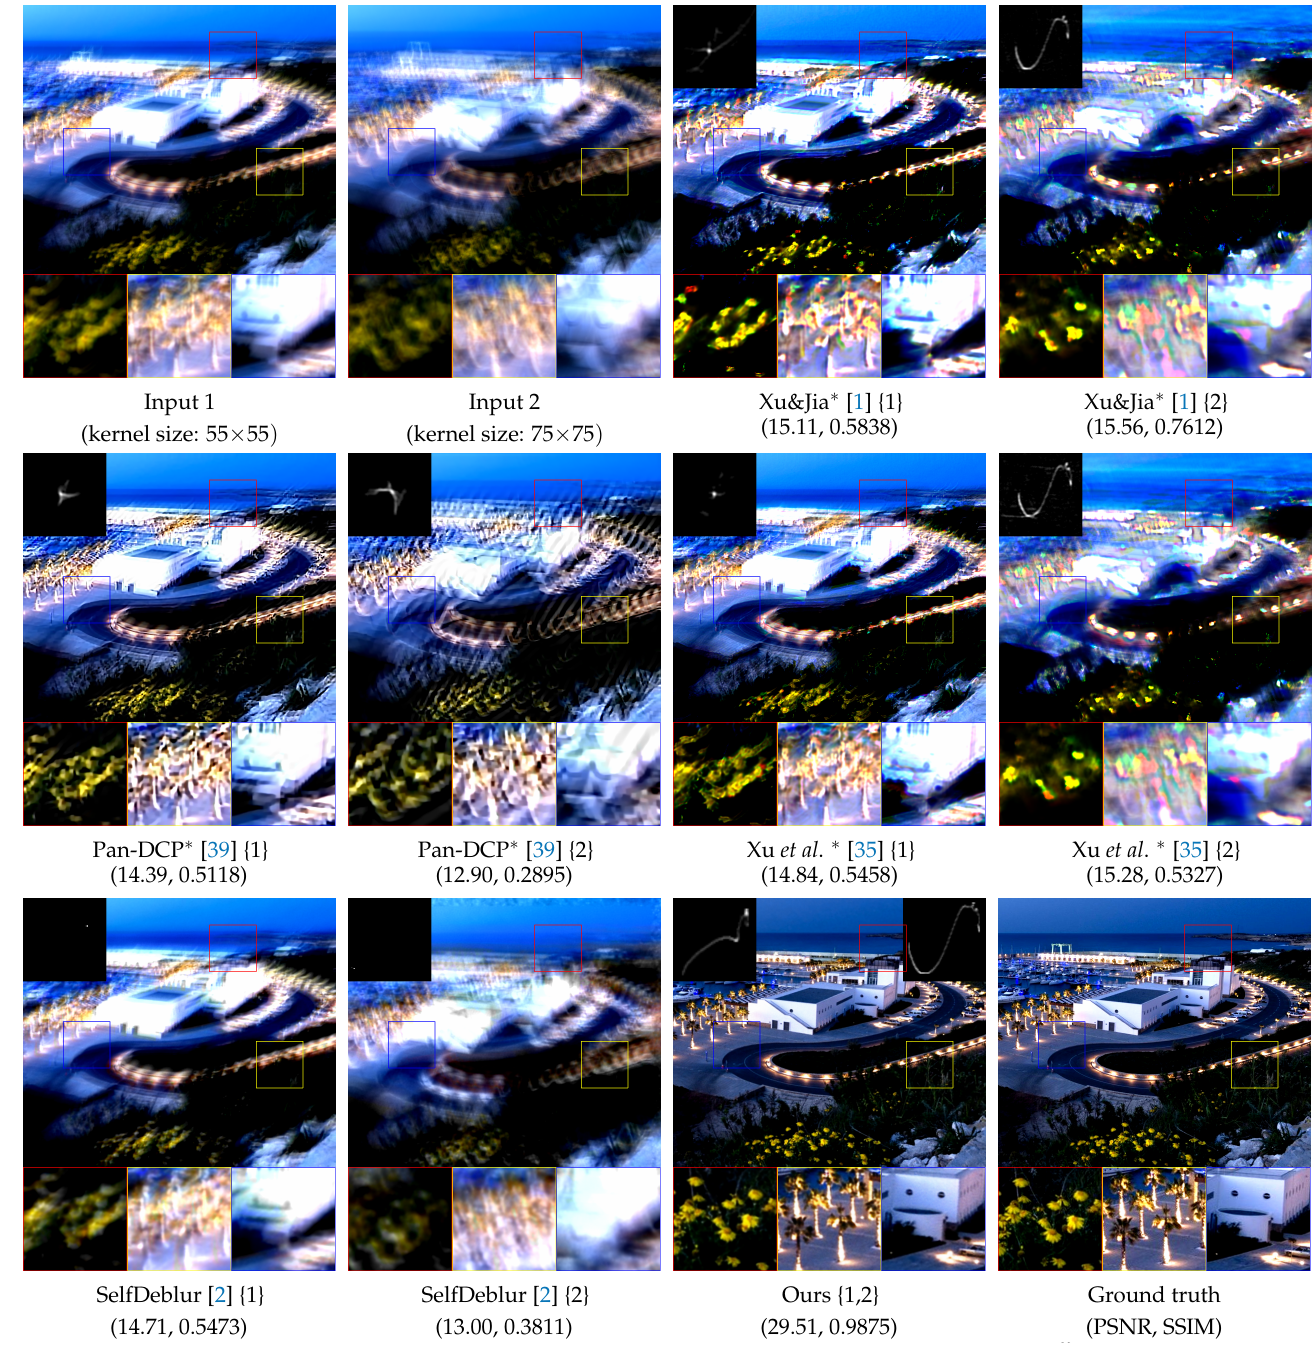
Figure 6. Qualitative comparisons on the Lai test set [45]. * indicates that the method uses the non-blind deconvolution method of [34] to produce the final result. The input image for each method is denoted as resulting image when the input images are input 1 and input